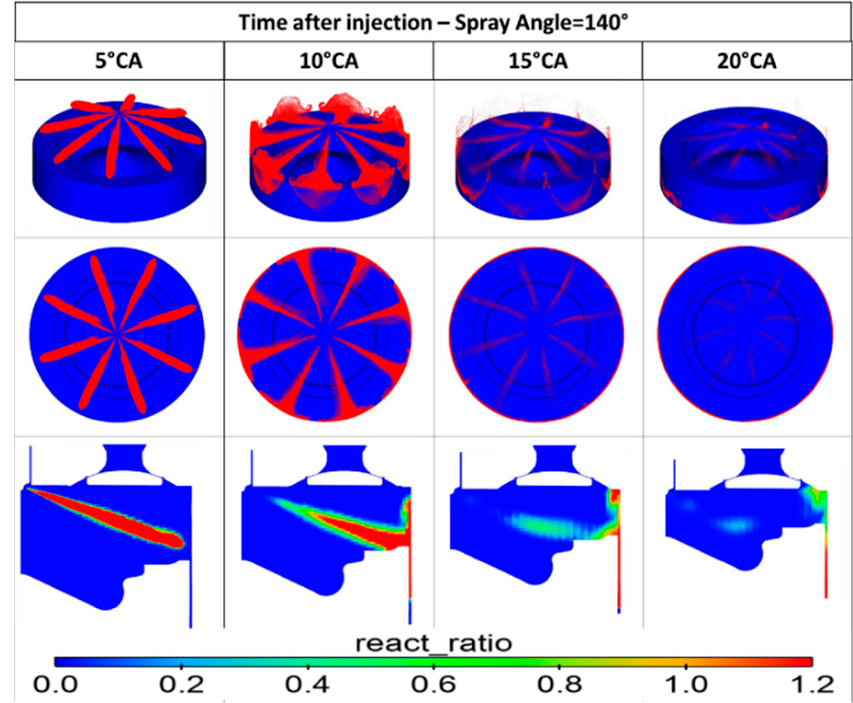
Figure 29. For am SIA of 140°, spray penetration in oblique side and top views and RER contour plot in a planar section through the cylinder axis and a spray axis.